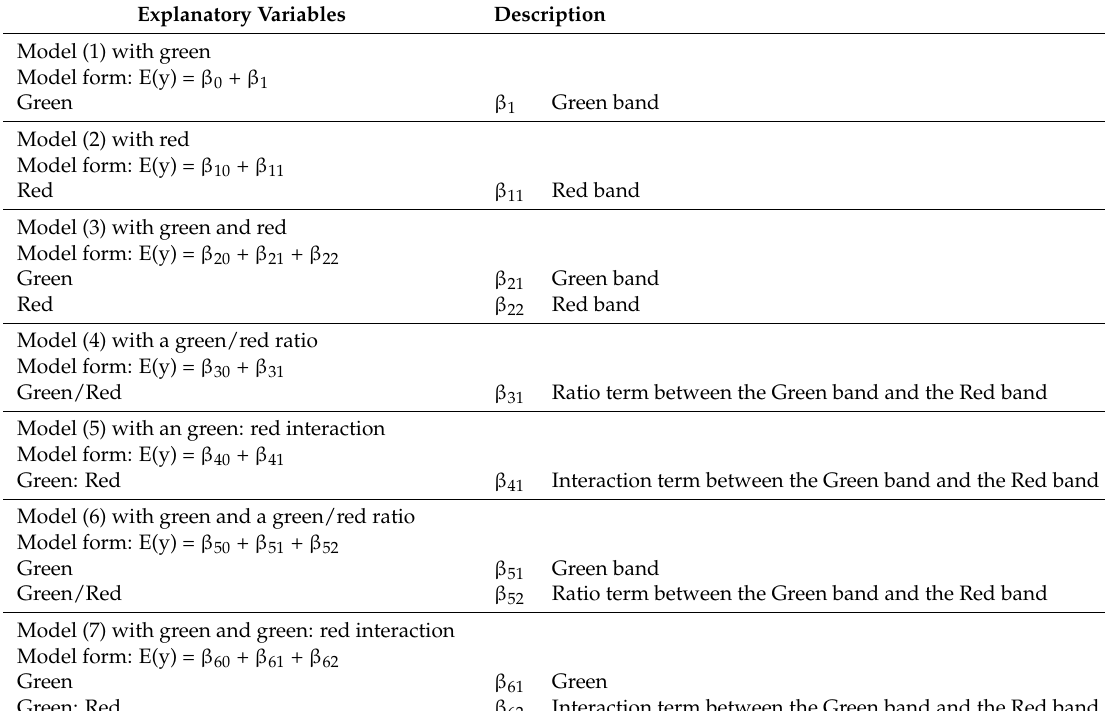
Table 2. Linear regressions tested to retrieve CDOM from green and/or red wavelengths in the Yenisei River.